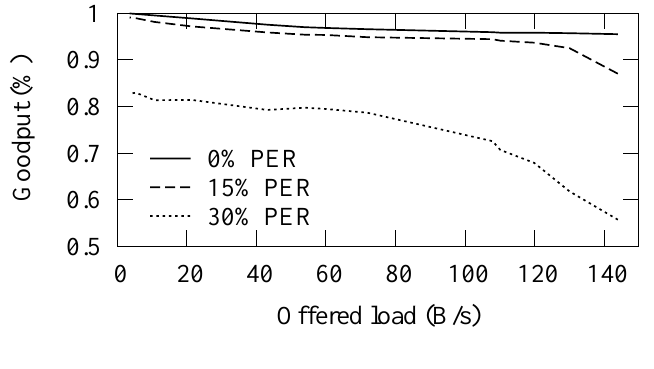
Figure 13. Goodput in TUTWSN with varying offered network load and different packet error